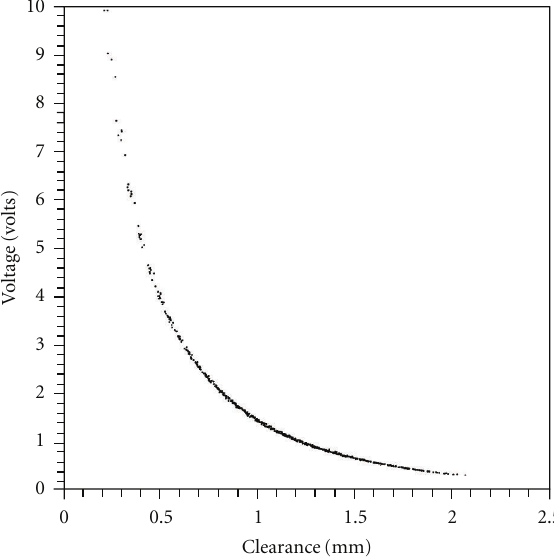
Figure 9: FM capacitance probe output plotted against known clearance illustrating the one over distance nature of the capacitance probe output. Each dot on the graph is a single measurement made over a single blade.